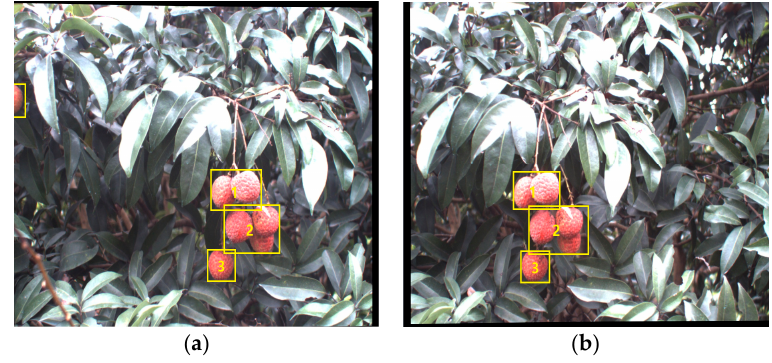
Figure 10. Clustered litchi fruits matching based on the proposed method. ( a ) left image; ( b ) right